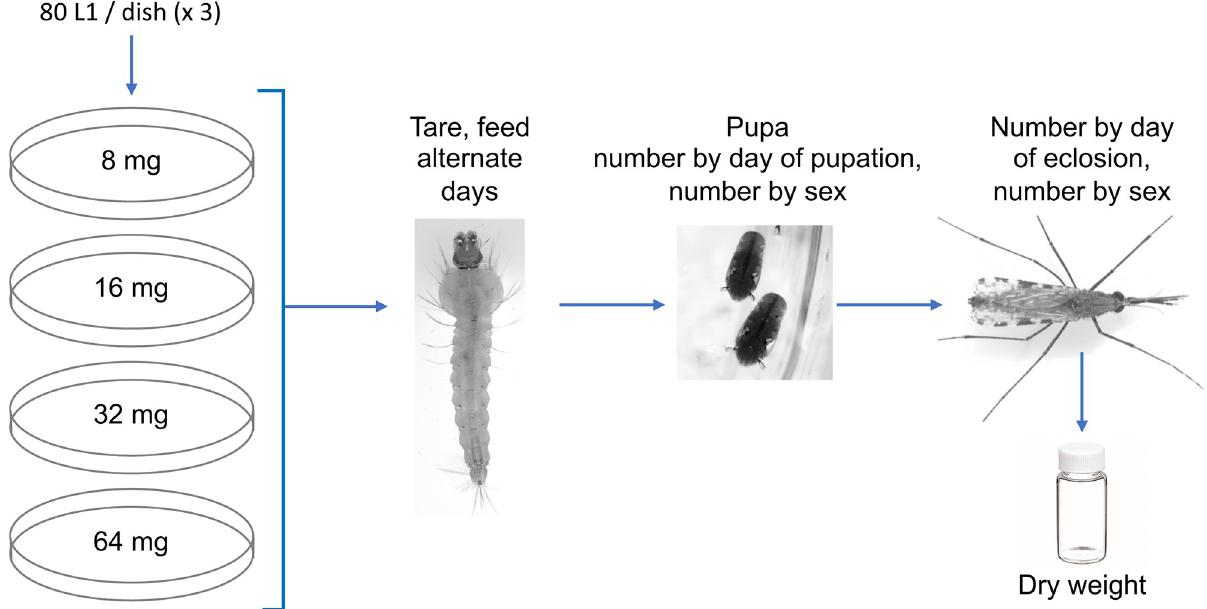
Fig 1. Experimental trial design. For each diet type tested, 12 dishes were observed, three at each diet type and level. When pupae formed, they were collected daily, their sex determined and transferred to tubes for eclosion. Adults were removed daily, dried overnight and weighed.